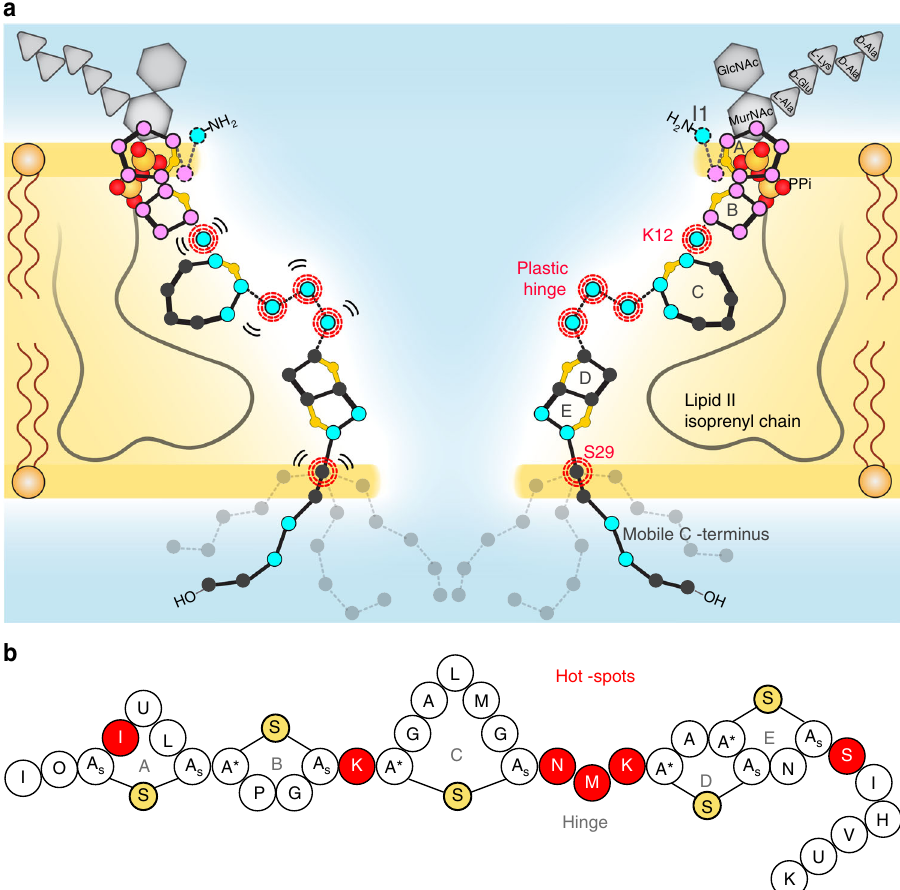
Fig. 4 The nisin:lipid II pore topology. a Membrane arrangement of the nisin:lipid II topology as seen by ssNMR. Plastic residues that are required to adapt to the bacterial target membrane are highlighted with red circles. Residues that showed 1 H/ 2 H exchange are colored in blue and align the pore lumen. The C terminus is dynamically disordered and resides at the water – membrane interface. The A – B rings (in magenta) interact with the lipid II PPi group. b Residues I4 32 , K12 38 , N20 – K22 15, 16, 20, 21, 30 , and S29 54 are pharmaceutical hotspots that enable to improve nisin ’ s activity upon mutation. These residues were all identi fi ed as important for nisin ’ s cellular adaptability in this